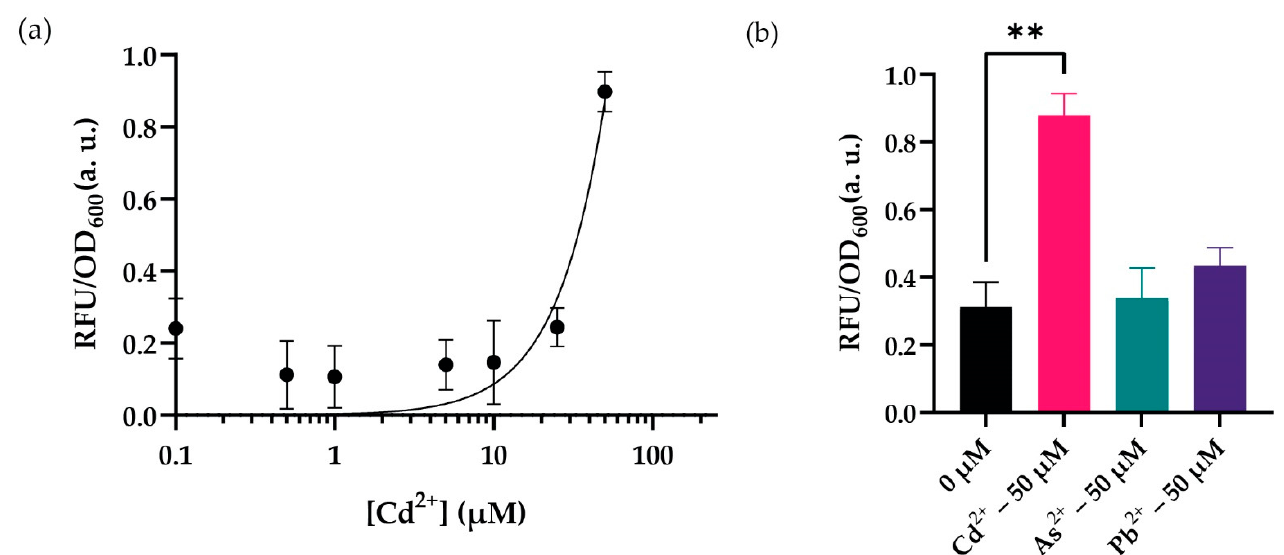
Figure 5. WCB activity with optimal conditions ( a ) Dynamic range analysis of the biosensor in optimal conditions with increasing concentrations (0–250 µ M) of cadmium ion. The point on the y -axis (0.0) represents the uninduced condition/background signal. ( b ) Cross-reactivity analysis comparing biosensor’s activity with lead and arsenic ions. For statistical analysis, multiple-t tests were implemented based on the group of interest. ** indicates p -value of <0.005, nonsignificant results have no stars. The p -value for arsenic ion’s fold change between 0 µ M and 50 µ M is 0.99. The p -value for lead ion’s fold change between 0 µ M and 50 µ M is 0.69. For both ( a ) and ( b ), the initial number of cells was 1:50 of culture volume. The cells were cultured in MOPS minimal media with a pH of 7.5 at 37 °C for 10 h. Measurements were taken for 96-well plates. The fluorescence intensity of each group was compared with each other and normalized according to the formula stated in the Materials and Methods section. Data were visualized with mean ± standard error mean (SEM) in each graph. At least three biological replicates were used for each analysis.